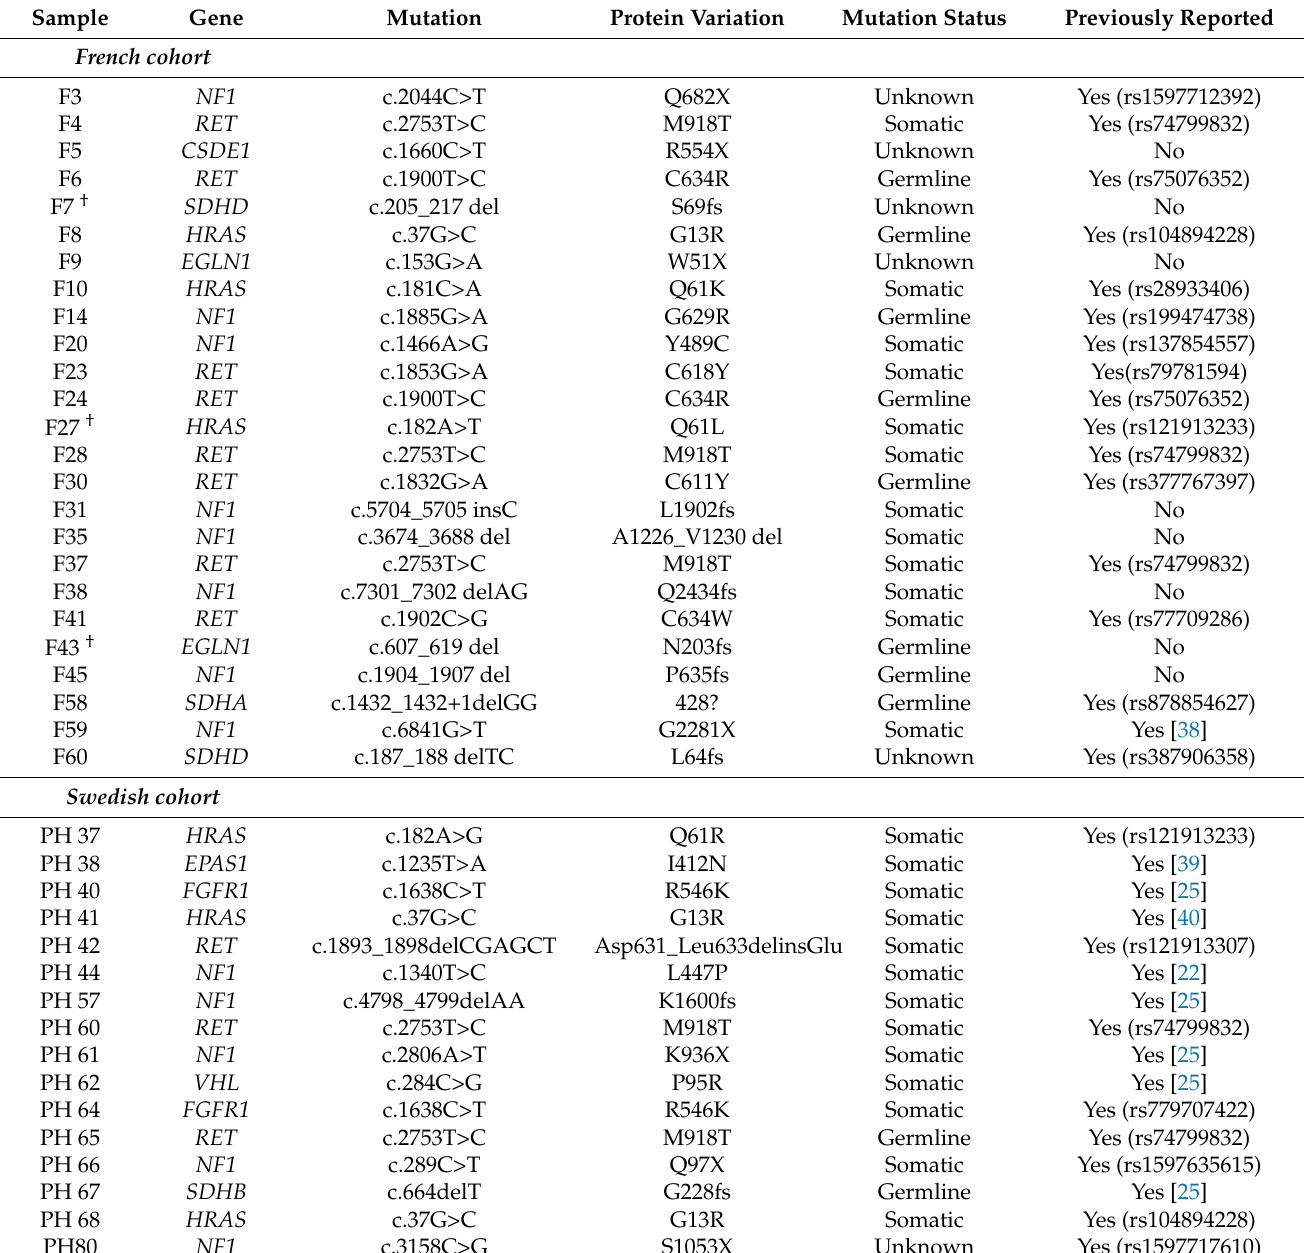
Table 1. Pathogenic mutations identified among 41 patients with pheochromocytomas and paragan- gliomas from Nancy, France, and from Linköping,